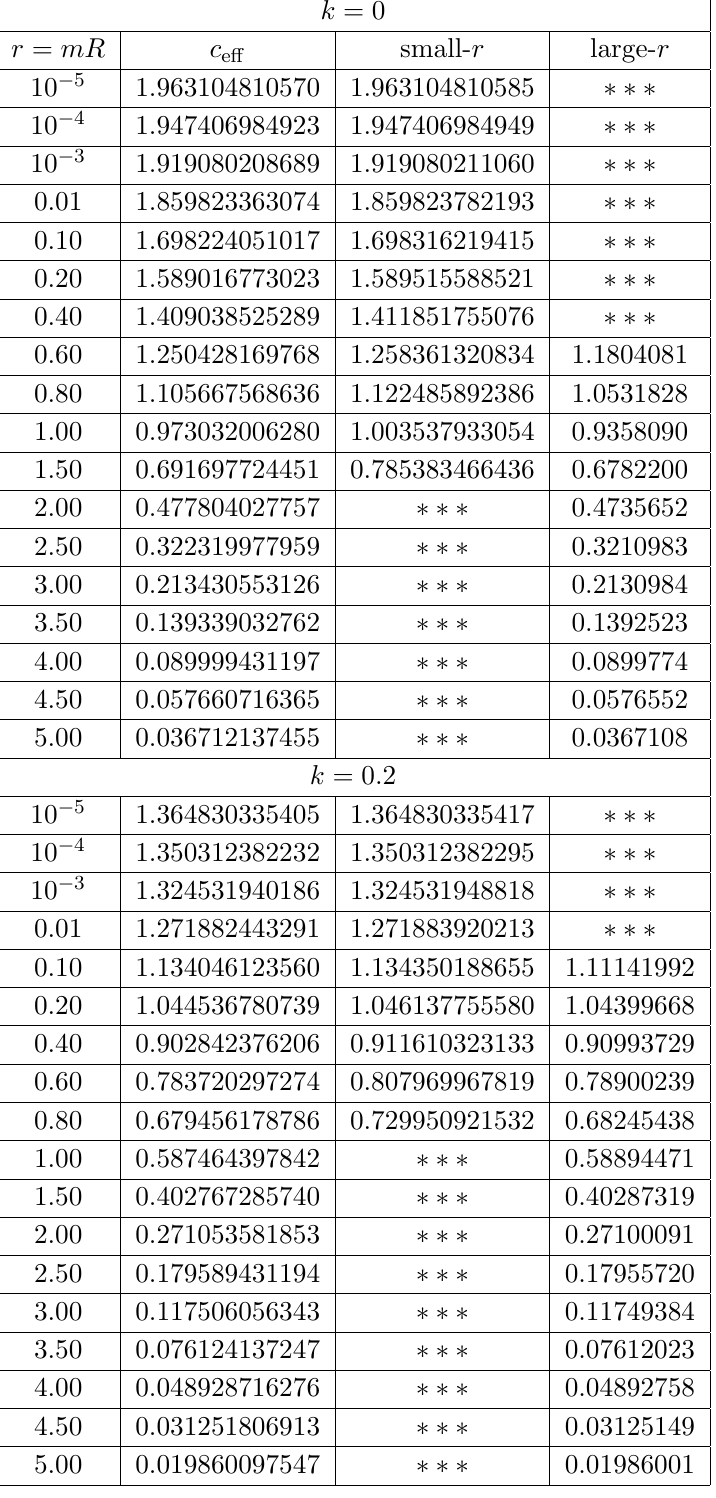
Table 1 . The numerical data for c e(cid:11) (cid:17) (cid:0) 6 F ( r; k ) with n = 0 : 5, k = 0 and 0 : 2. The small- r asymptotic was obtained by (5.24) whereas the large- r asymptotic comes from (5.27).